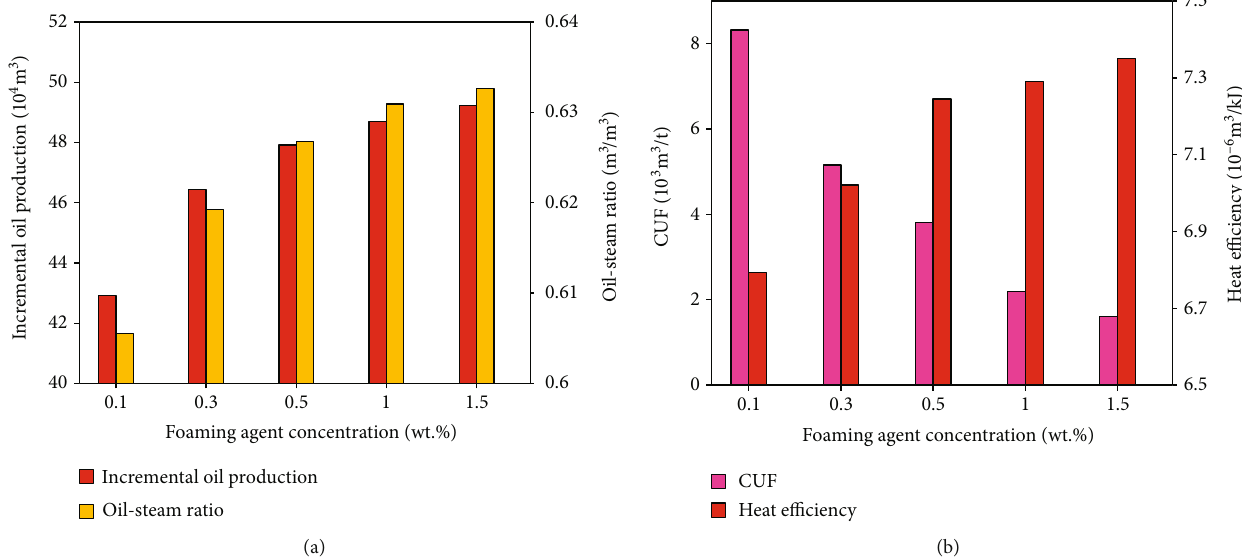
Figure 6: E ff ect of the foaming agent concentration: (a) incremental oil production and oil-steam ratio; (b) CUF and heat e ffi